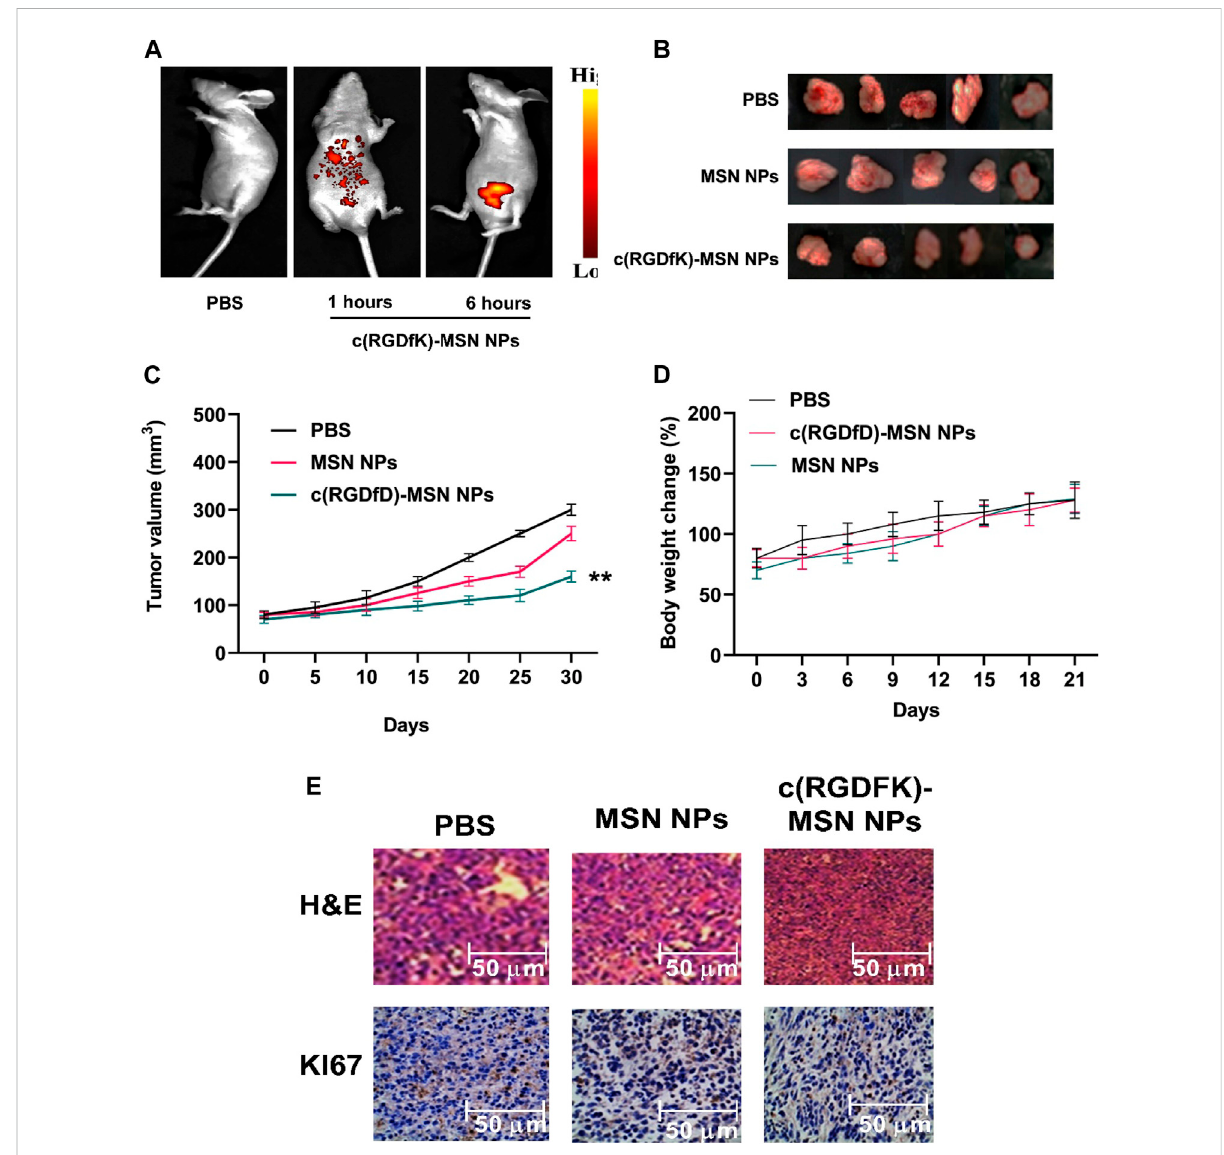
FIGURE 7 (A) In vivo fl uorescence imaging from mice injected intravenously with saline and c(RGDfD)-MSN NPs. (B) Tumor volume images, (C) tumor volume curve, (D) body weight curve, and (E) H&E staining and IHC image (×400 magni fi cation) of Ki67 of mice after treatment with PBS, c(RGDfD)- MSN NPs, and MSN NPs. The scale bar is 50